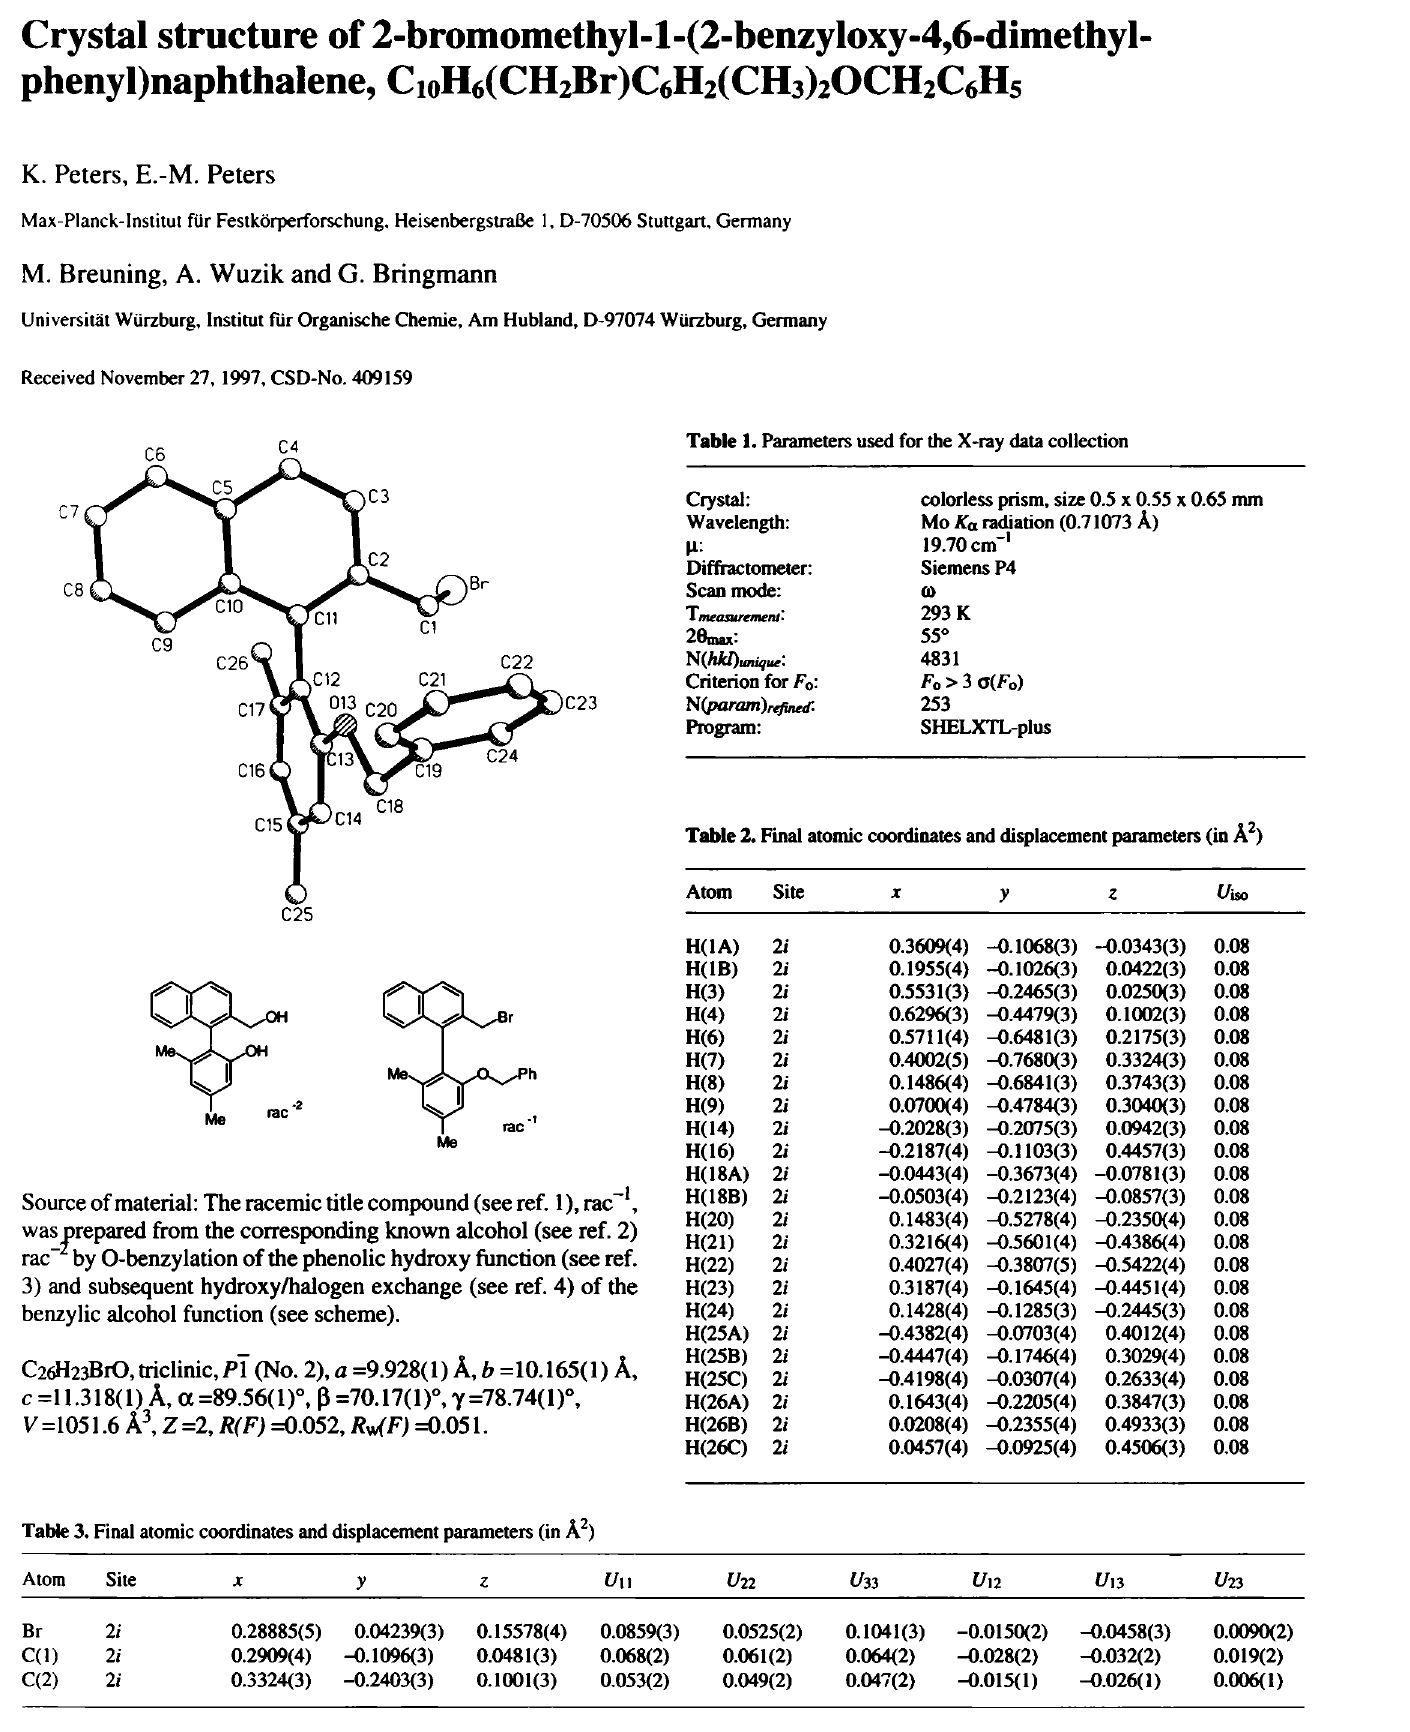
Table 3. Final atomic coordinates and displacement parameters (in Â?) Atom Site